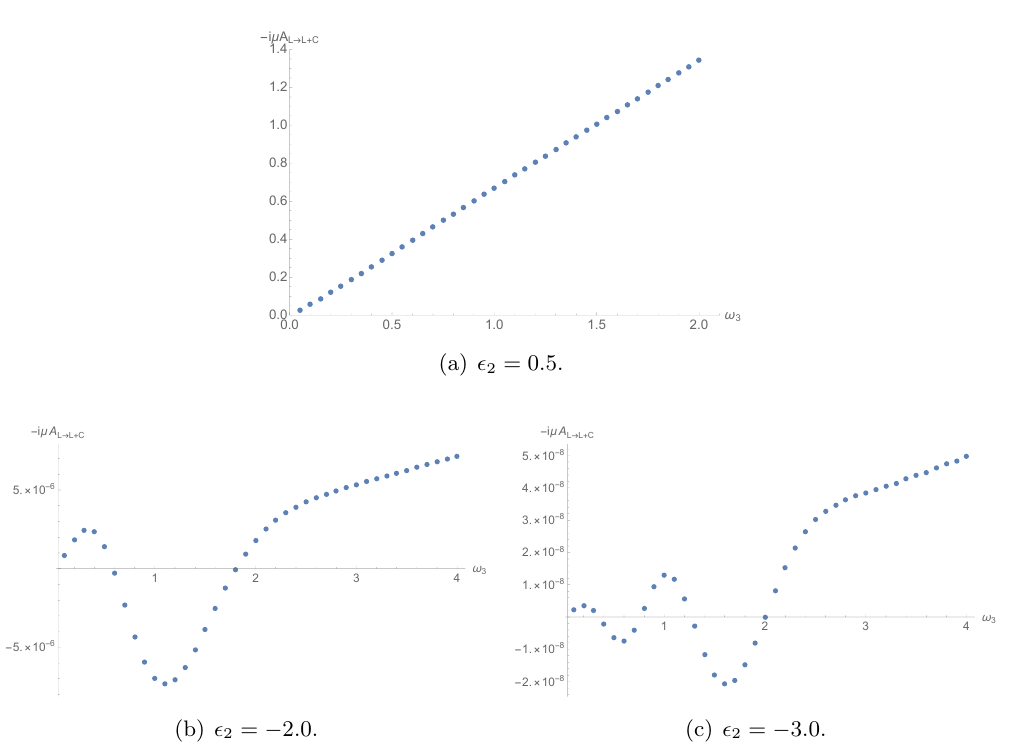
Figure 6 . Long string amplitude A L ! L + C (rescaled by (cid:22) ) evaluated at (cid:12)xed outgoing long string energy (cid:15) 2 as a function of closed string energy ! 3 .